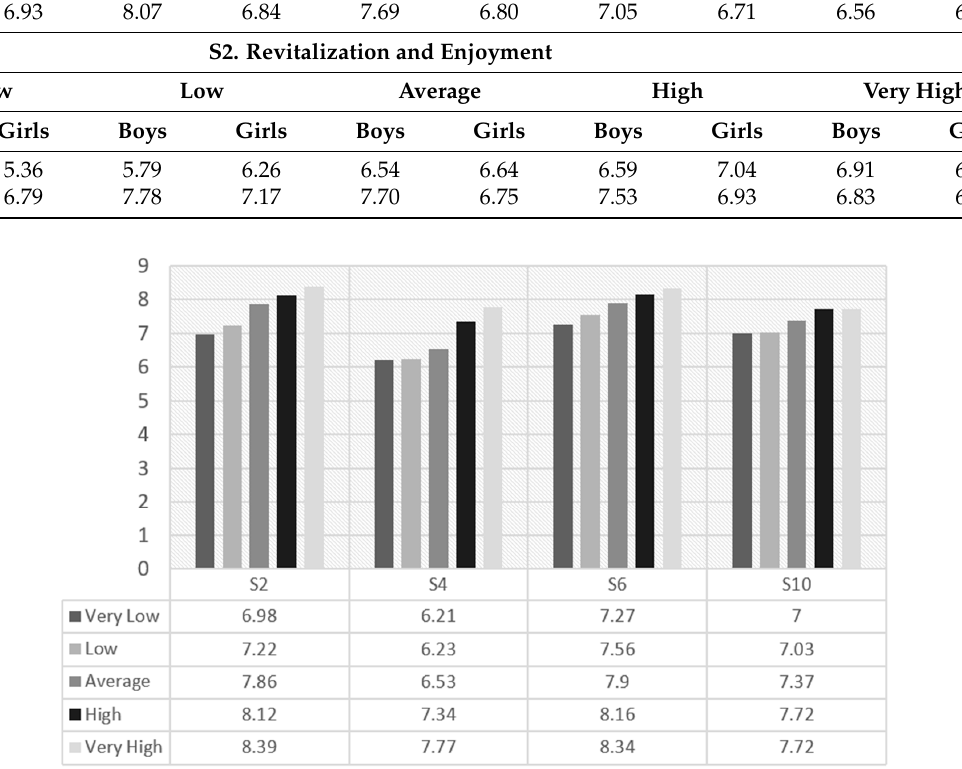
Figure 1. S2 (Revitalization and Enjoyment), S4 (Competition), S6 (Strength and Endurance), and S10 (Challenge) subscales scoring by cardiorespiratory fitness in boys.